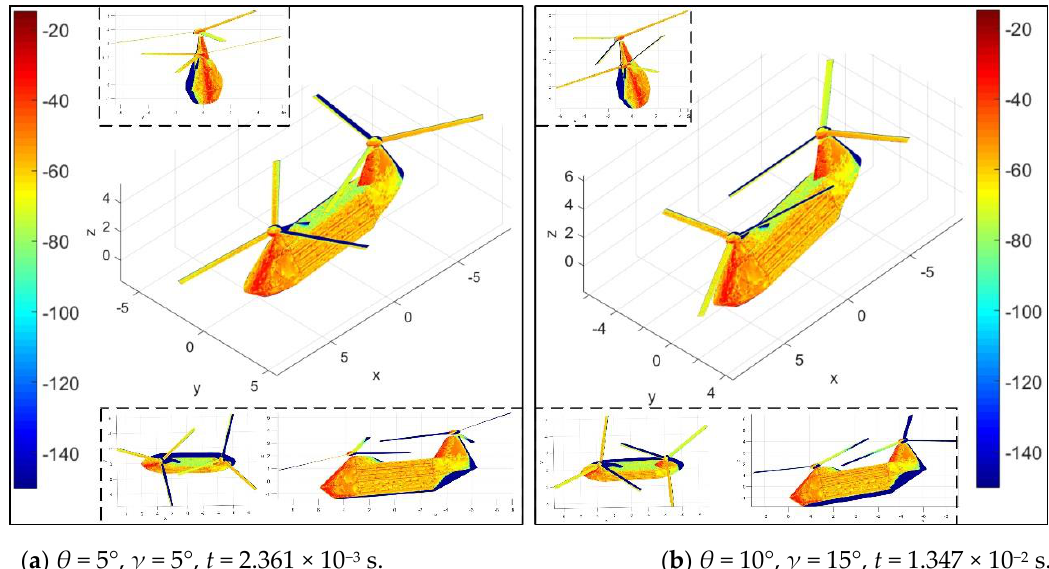
Figure 14. Surface scattering characteristics of helicopter at various attitude angles, f RH = 10 GHz, n r1 = n r2 = 1200 r/min, α = 25°, β = 0°, A df = A dr = 5°, RCS unit: dBm 2 .